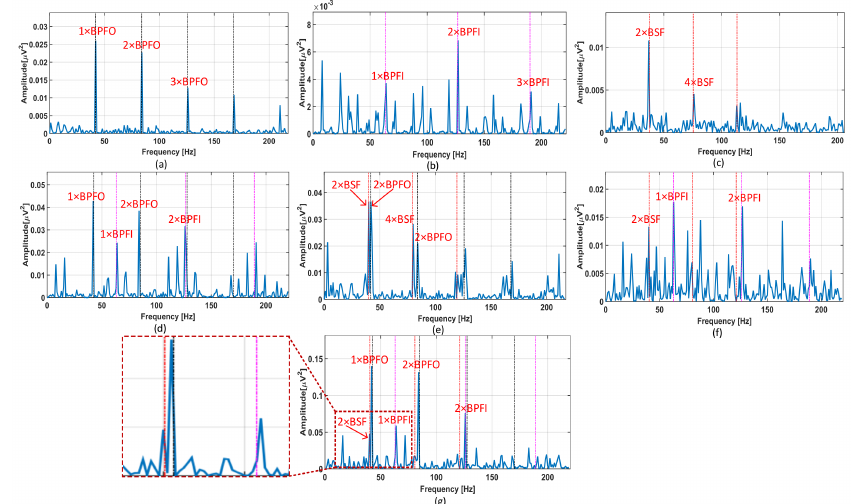
Figure 2. Envelop spectrum of seven types of fault signals: ( a ) Bearing-Crack-Outer; ( b ) Bearing-Crack-Inner; ( c ) Bearing-Crack-Roller; ( d ) Bearing-Crack-Outer-Inner; ( e ) Bearing-Crack-Outer-Roller; ( f ) Bearing-Crack- Inner-Roller; ( g ) Bearing-Crack-Outer-Inner-Roller.